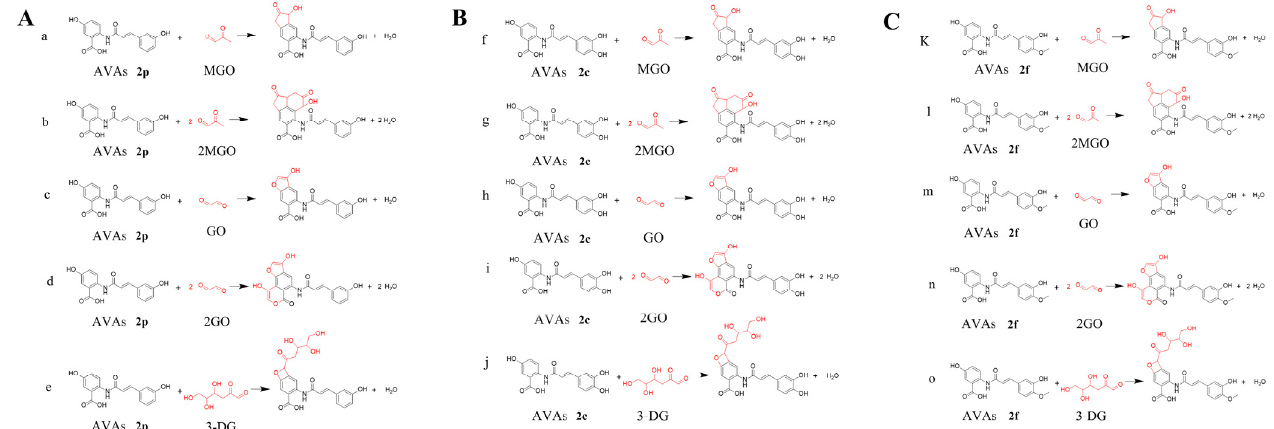
Figure 4. ( A ) Synthetic mechanism diagram of AVA 2p with MGO ( a ), 2MGO ( b ), GO ( c ), 2GO ( d ), and 3-DG ( e ). ( B ) Synthetic mechanism diagram of AVA 2c with MGO ( f ), 2MGO ( g ), GO ( h ), 2GO ( i ), and 3-DG ( j ). ( C ) Synthetic mechanism diagram of AVA 2f with MGO ( k ), 2MGO ( l ), GO ( m ), 2GO ( n ), and 3-DG ( o ).